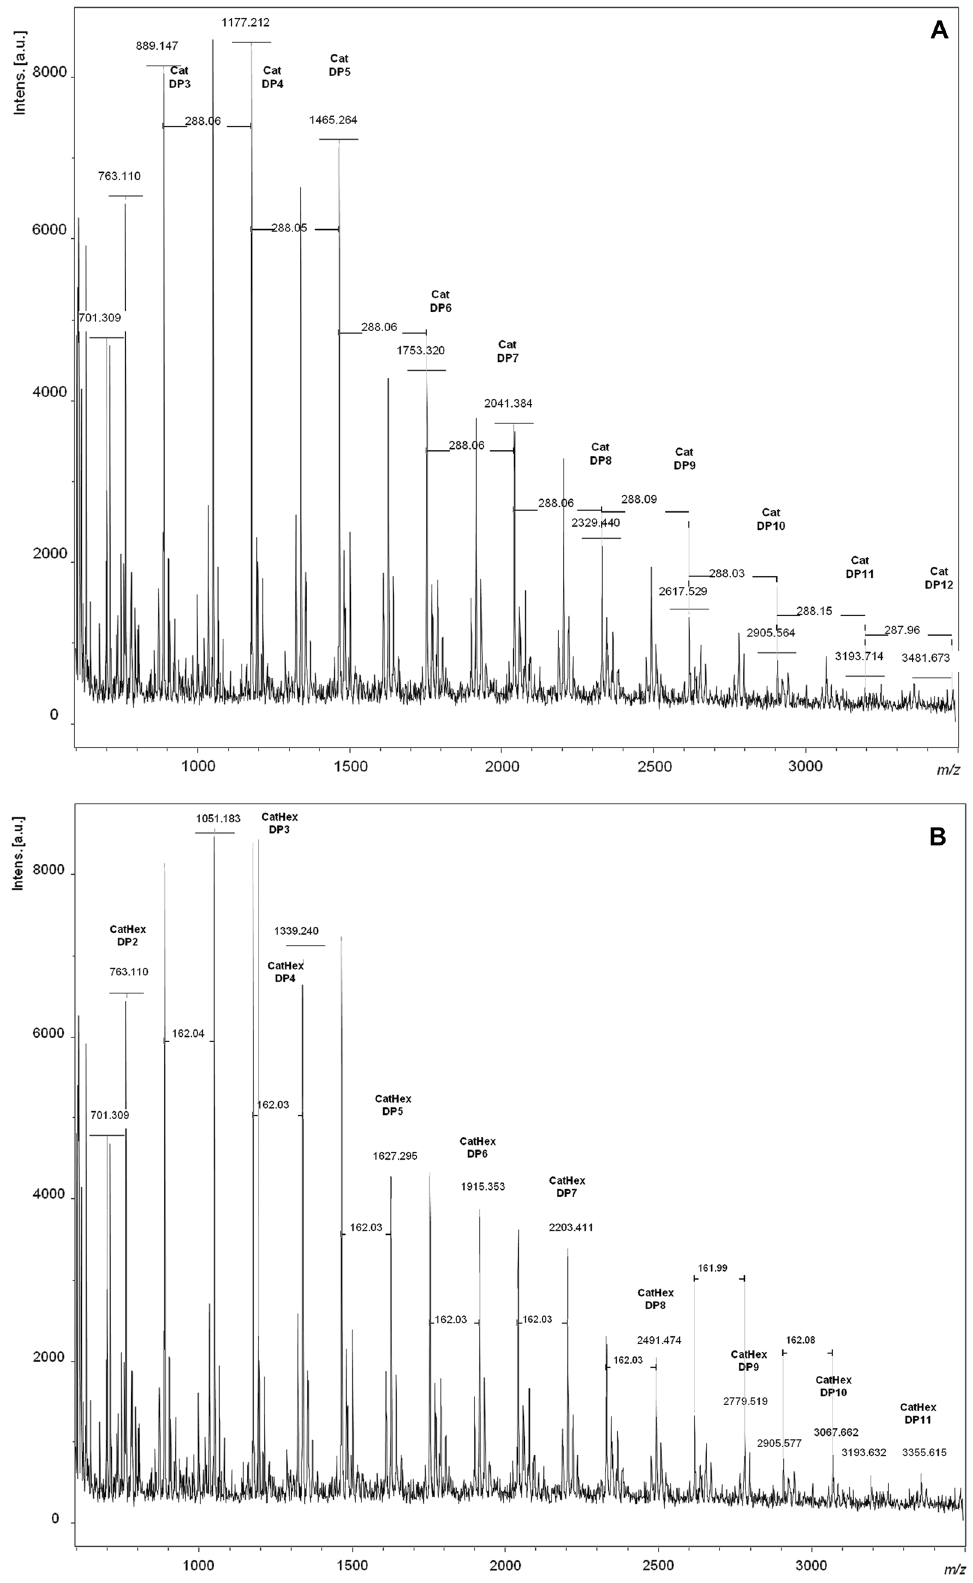
Fig. 2 MALDI-TOF positive reflectron mode mass spectra of the condensed tannins from R. mangle . A catechins series with varying hydroxylation patterns, B catechins series with hexose group and varying hydroxylation